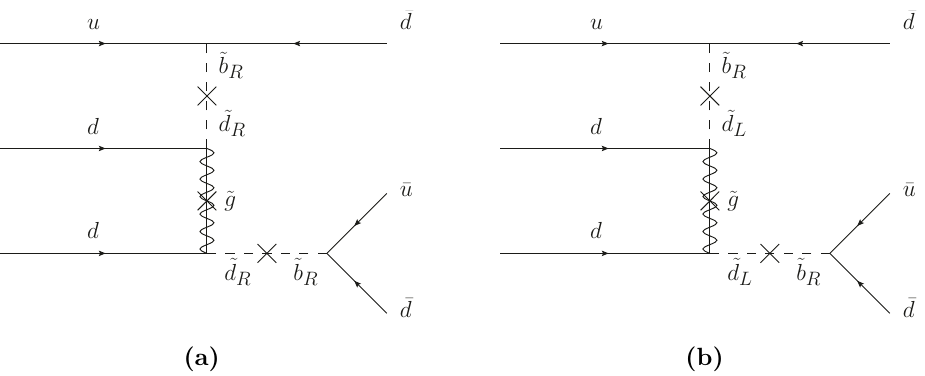
Figure 1. Diagrams leading to neutron antineutron oscillation. Flavour changing insertions are needed on the squark lines and a Majorana mass insertion is needed on the gluino line. (a) shows a diagram with (cid:13)avour changing insertions of the right-handed squarks. (b) shows a diagram requiring a left-right squark mixing which is further suppressed by the gravitino